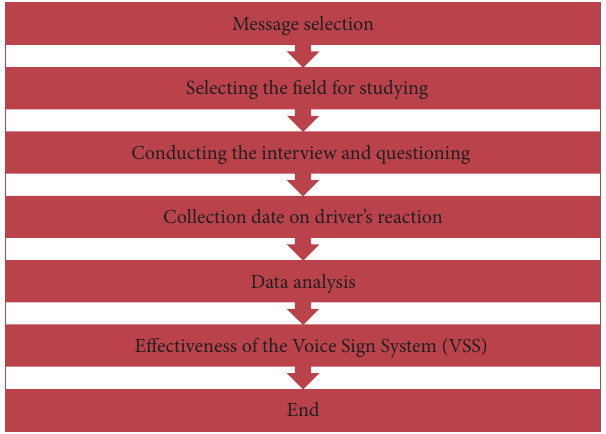
Figure 2: The radio transmitter and accessories.